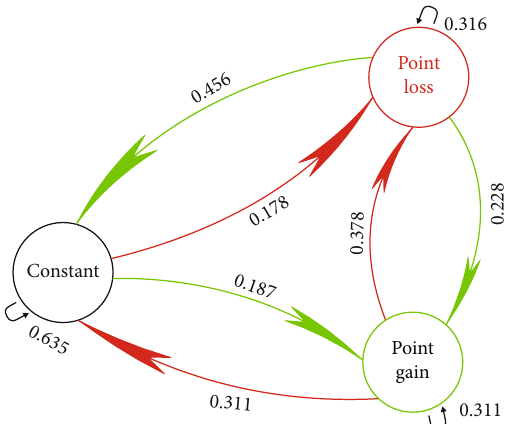
Figure 3: ADB equity transition matrix and diagram.